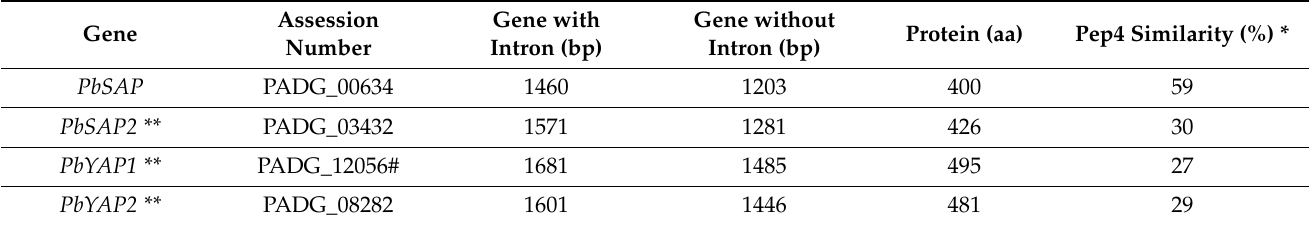
Table 2. Characteristics of the genes encoding aspartic proteases in P. brasiliensis .